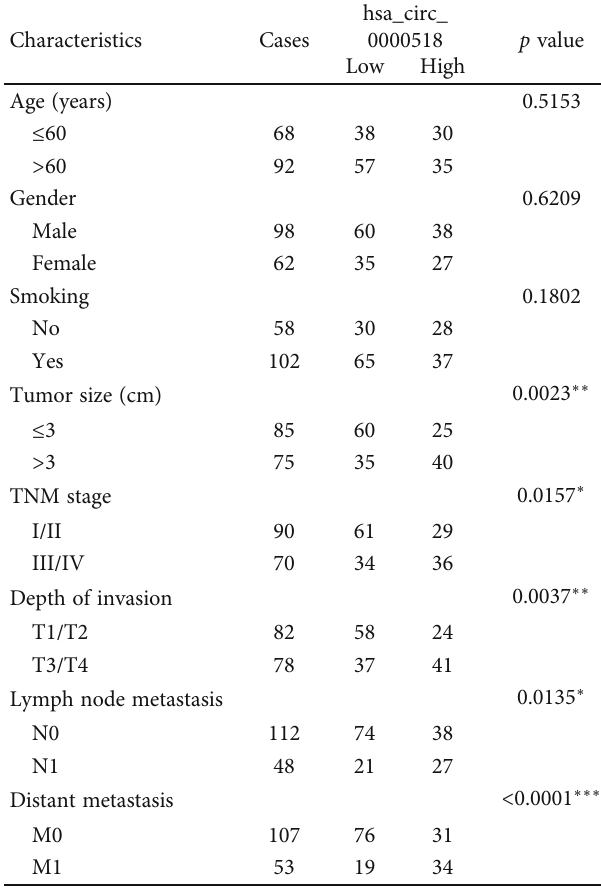
Table 1: Correlations between hsa_circ_0000518 levels and clinicopathological features of